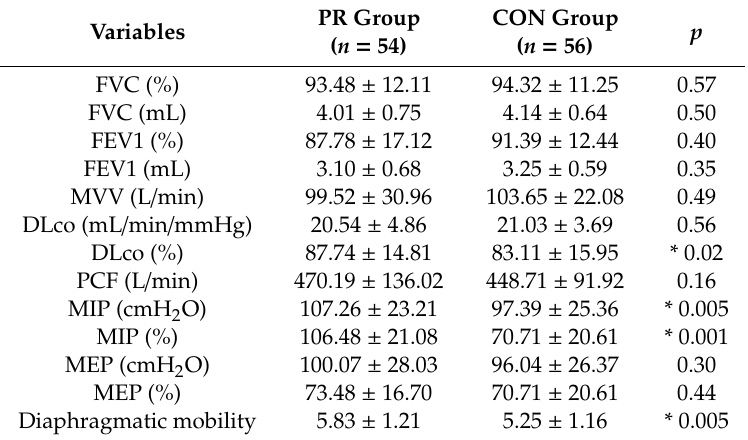
Table 4. Pulmonary function measurements after 12